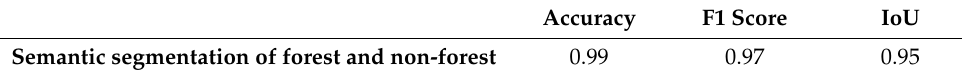
Table 2. Overall performance evaluation of the selected U-Net model.